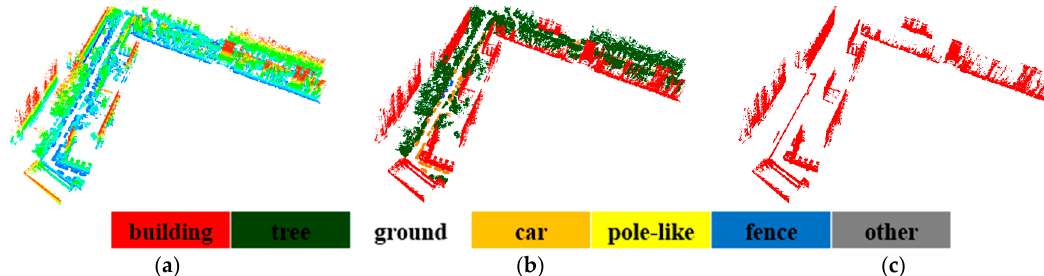
Figure 13. The results of building extraction on dataset C. ( a ) Raw data; ( b ) the final results of semantic segmentation; ( c ) the results of building extraction.